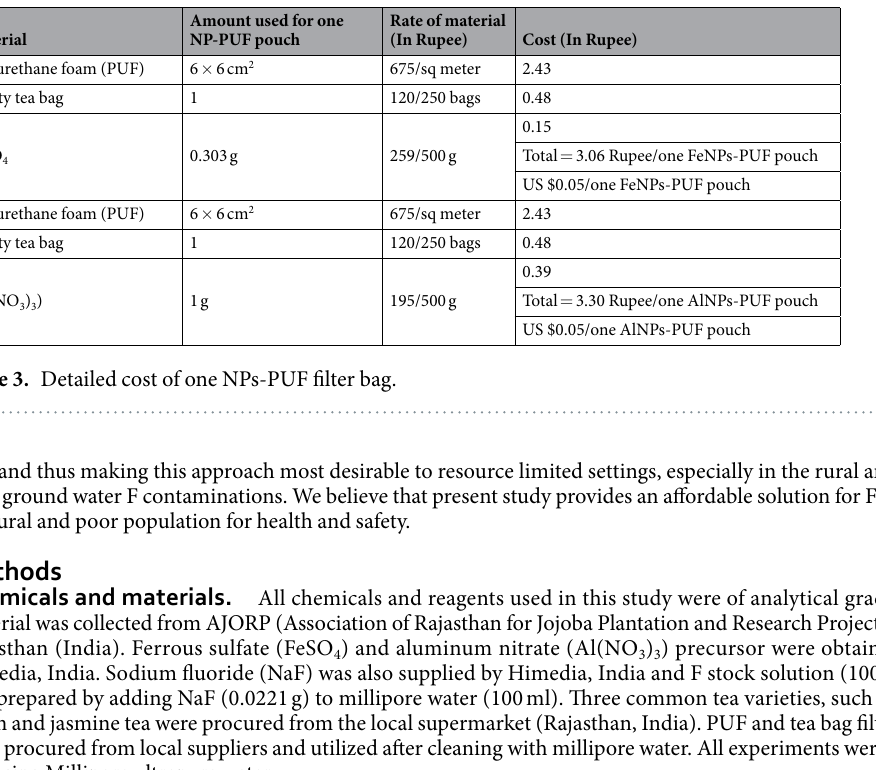
Amount used for one NP-PUF pouch